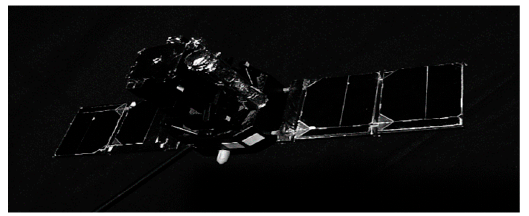
Figure 14. Sample test image.